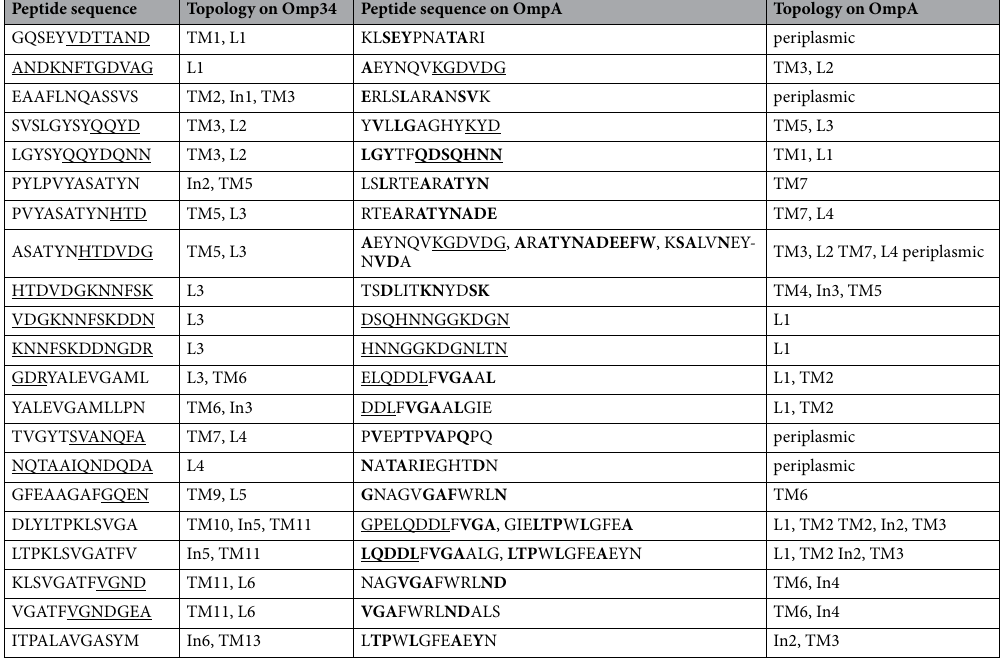
Table 2. Topology of the similar OmpA and Omp34 peptides. Exposed residues located in external loops are underlined. TM transmembrane, In internal turns, L external loops.